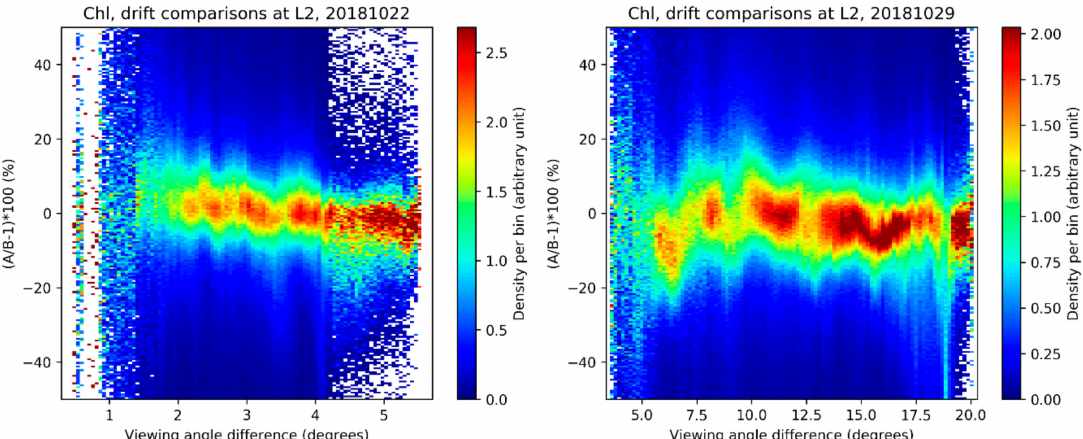
Figure 20. Relative di ff erences of OLCI-A and OLCI-B chlorophyll as function of the viewing angle di ff erence for the two drift dates available in the archive ( left : 22nd October, 3 min apart; right : 29th October, 9 min apart). Density histograms are made per viewing angle